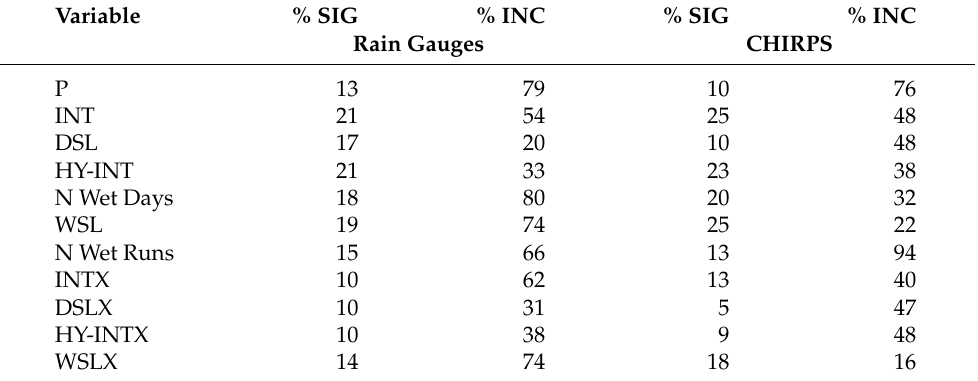
Table 1. Basic statistical analysis for the trends in base dataset (909 stations) and in CHIRPS dataset (37012 cells covering Colombia). Columns show percentage of significant trends (SIG) and percentage of increasing trends as a proportion of the significant ones (INC). Results for the following variables: P: Total Annual Precipitation, INT: averaged scaled intensity on wet days, DSL: averaged scaled dry run length; HYI-NT = INT × DSL; N stands for the number; WSL: averaged scaled length of wet runs; INTX: the maximum daily intensity; DSLX: the maximum dry run length; HY-INTX = INTX × DSLX; and WSLX: the maximum wet run